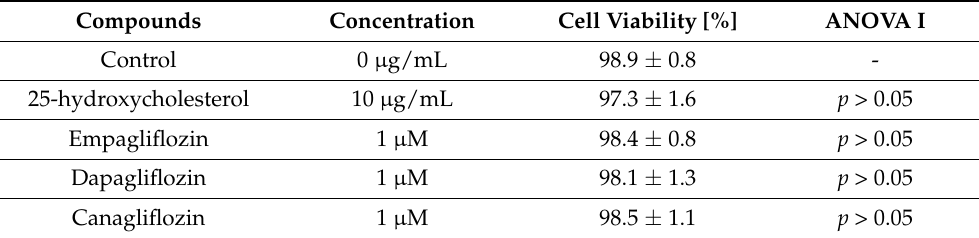
Figure 3. The expression and distribution of VE-cadherin in endothelial cells after treatment with 25-OHC and selected flozins. HUVEC cells were treated with medium (control), 10 µ g/mL 25-OHC (4 h), followed by 24 h incubation with or without 1 µ M dapagliflozin, empagliflozin, or canagliflozin. ( A ) Cells were stained for VE-cadherin (green) and DAPI (blue). ( B ) Quantification of VE-cadherin protein levels measured as mean fluorescence intensity in cell membrane ( n = 30–40 cells). ( C ) Visualization by color mask (red) of all fluorescence points with intensity ≥ 1000. ( D ) The selected enlargements of a mature cell–cell junction (red frames). White scale bars represent 20 µ m. Data are presented as mean ± SD. * p < 0.05, ** p < 0.01, and **** p < 0.0001. Table 3. The level in the viability level of human HUVECs was determined by the trypan blue dye exclusion test. HUVECs were induced by 25-hydroxycholesterol (10 µ g/mL), empagliflozin, dapagliflozin, and canagliflozin (1 µ M). Mean ± SD was calculated from nine individual experiments. Statistical analysis was conducted using one-way ANOVA and post hoc Tukey’s test.